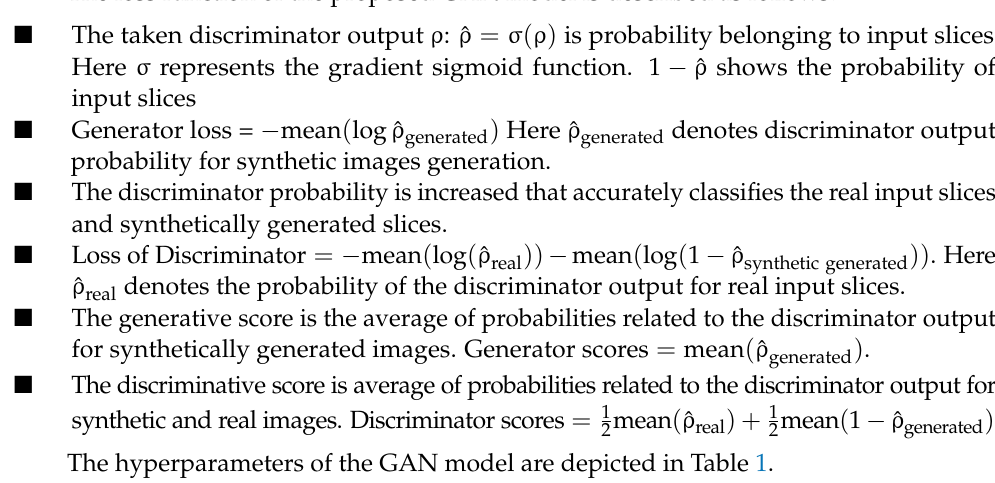
Table 1. Parameters of GAN model.